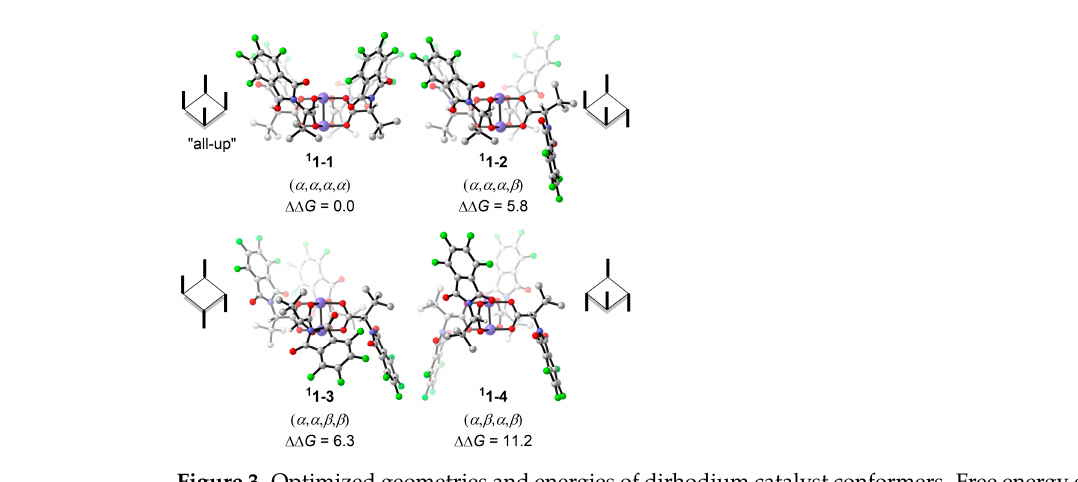
Figure 3. Optimized geometries and energies of dirhodium catalyst conformers. Free energy obtained at the M06/def2-TZVP//BPW91/6-31G*-LANL2DZ level. Energies are shown in kcal mol − 1 . The H atoms of t Bu groups are omitted for clarity.